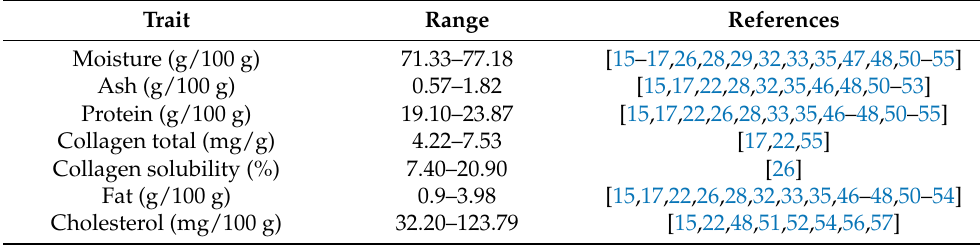
Table 3. Chemical composition of river buffalo meat. Trait